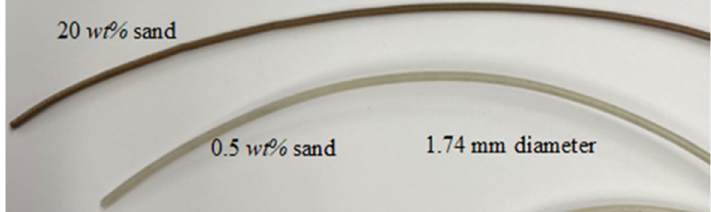
Figure 4. Sample of the fabricated PLA-sand filaments with 20 and 0.5 wt% sand.